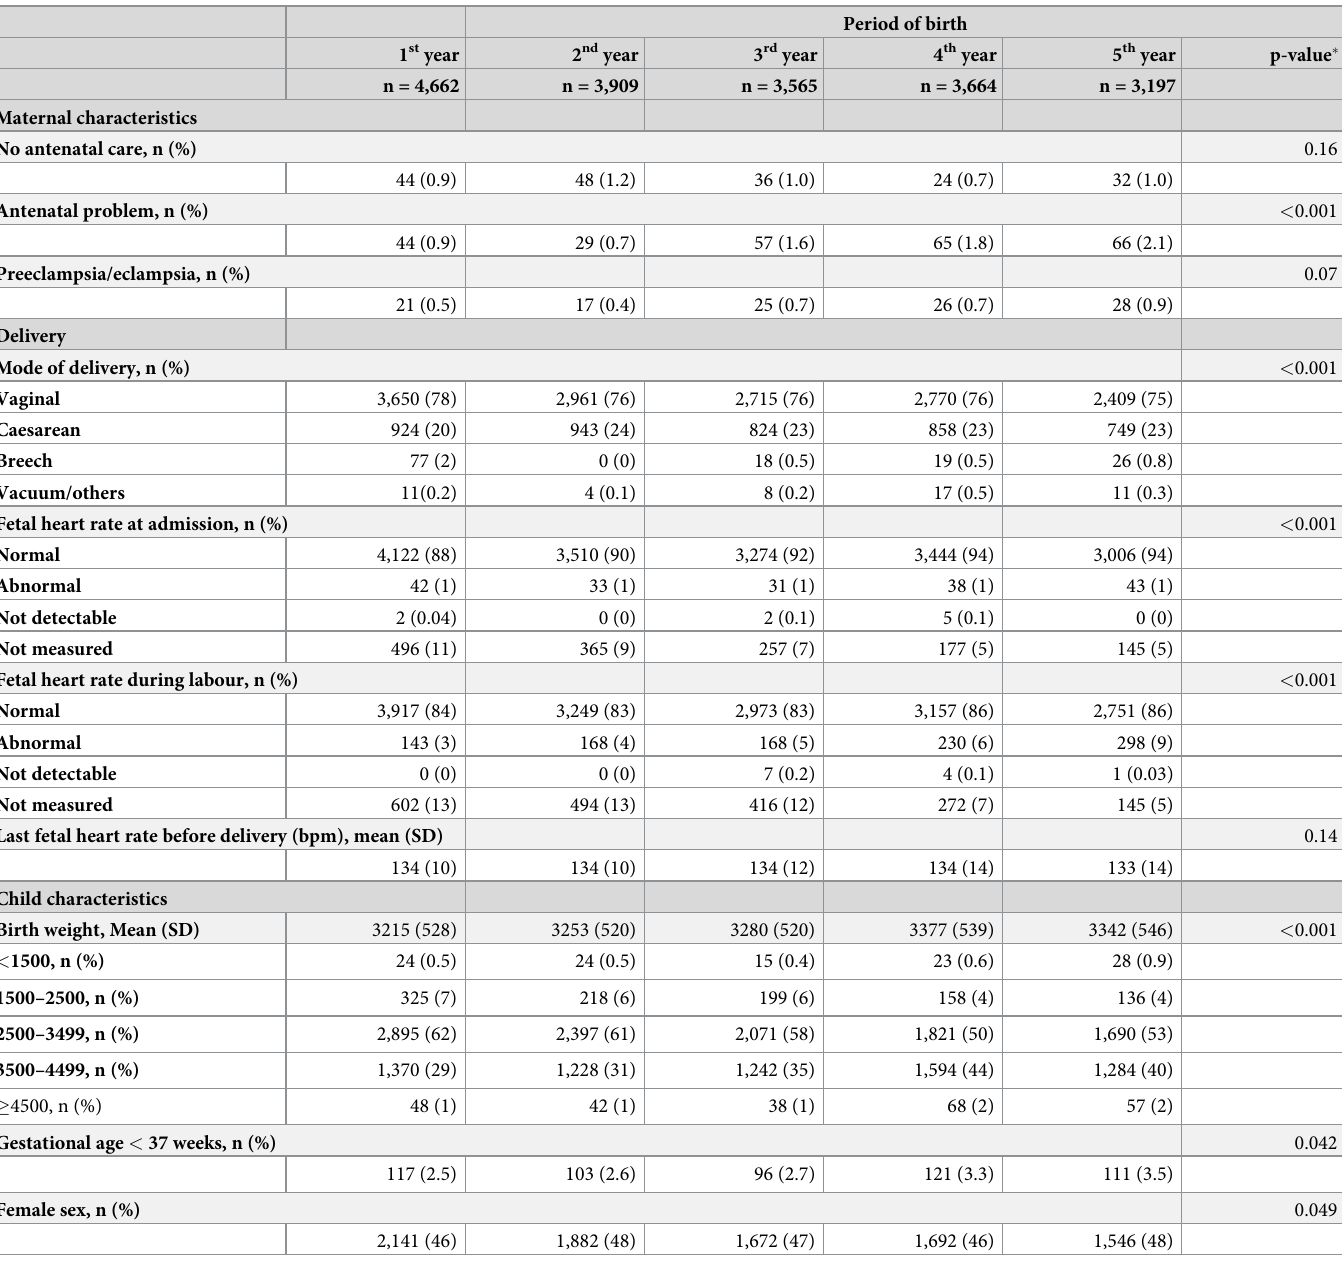
Table 1. Baseline characteristics of live births at Haydom 1.7.2013–30.6.2018 (n =